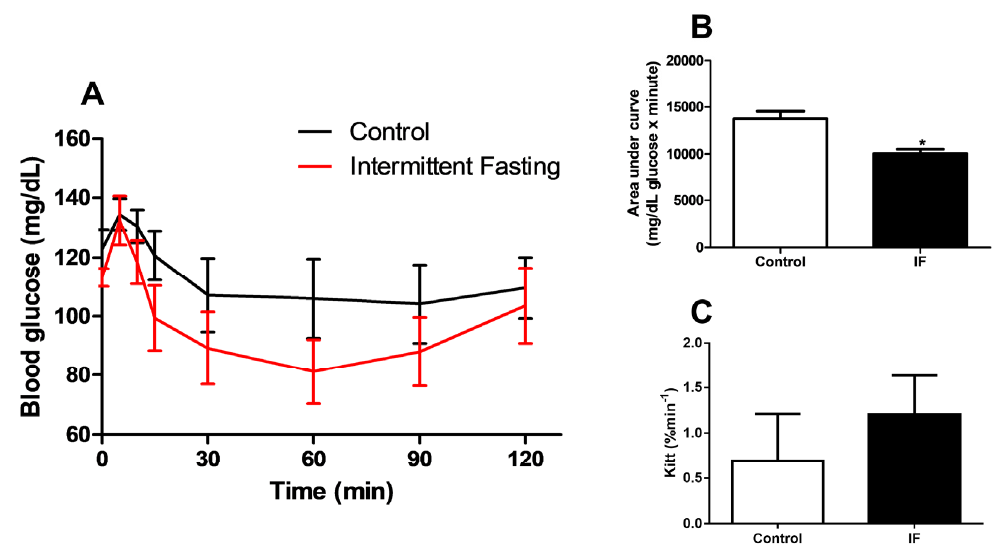
Figure 7. ( A ) Intraperitoneal insulin tolerance test (iITT), ( B ) area under curve and ( C ) glucose decay constant rate during insulin tolerance test (kITT) of Wistar rats submitted to IF for 12 weeks. The results are presented as means ± standard error of the mean (SEM) with 5 di ff erent animals for each group. * p < 0.05 compared to the control, as indicated by Student’s t-test (B and C), two-way ANOVA followed by Sidak’s multiple comparisons test